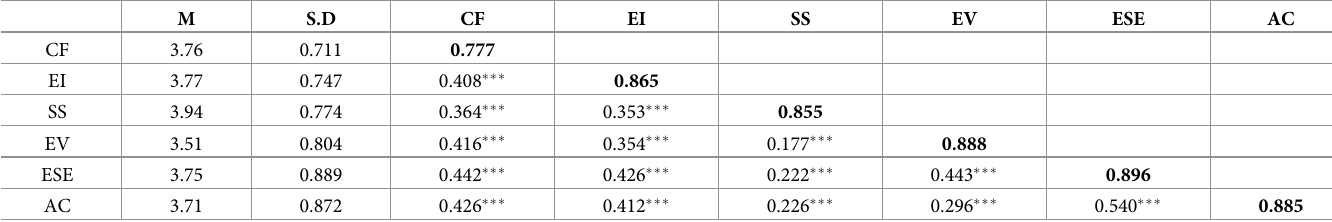
Table 3. Discriminant validity and